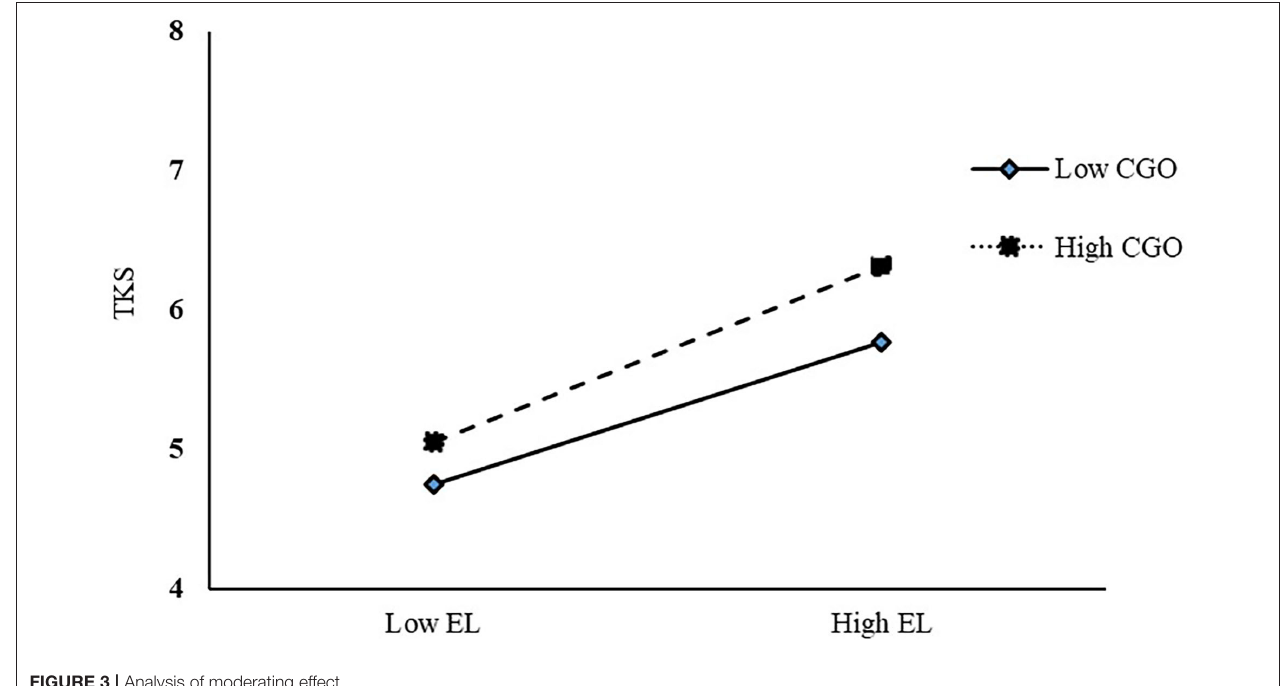
FIGURE 3 | Analysis of moderating effect.